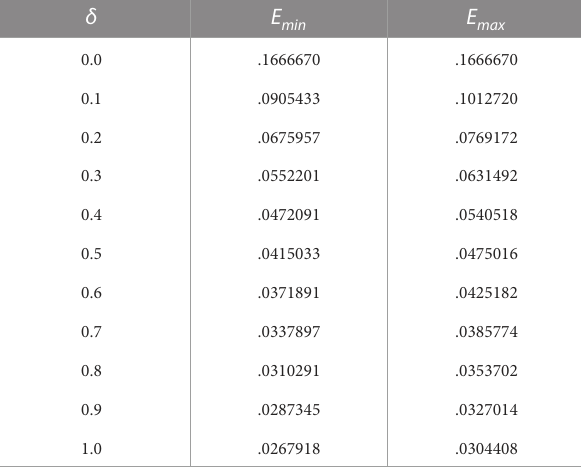
TABLE1 Criticalvaluesofenergyatdifferentvaluesofthetransition parameterforboundedmotion ( E < E min ) andunboundedmotion ( E > E max )